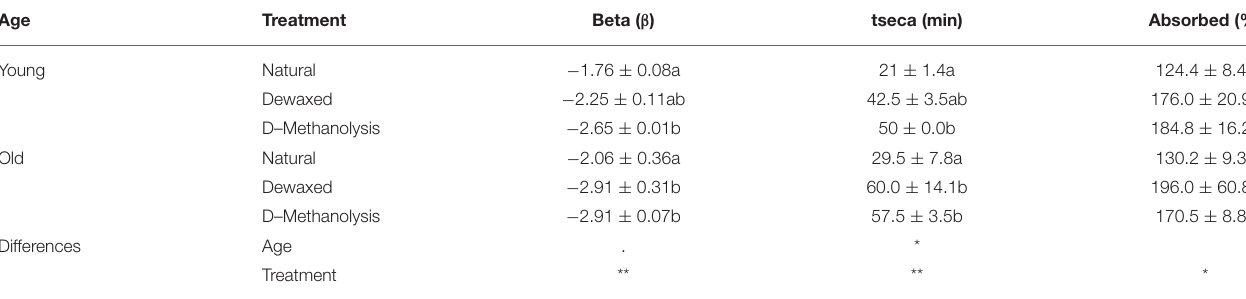
TABLE 2 | Transpiration parameters of holly leaf adaxial cuticles, as affected by chemical treatment and age.